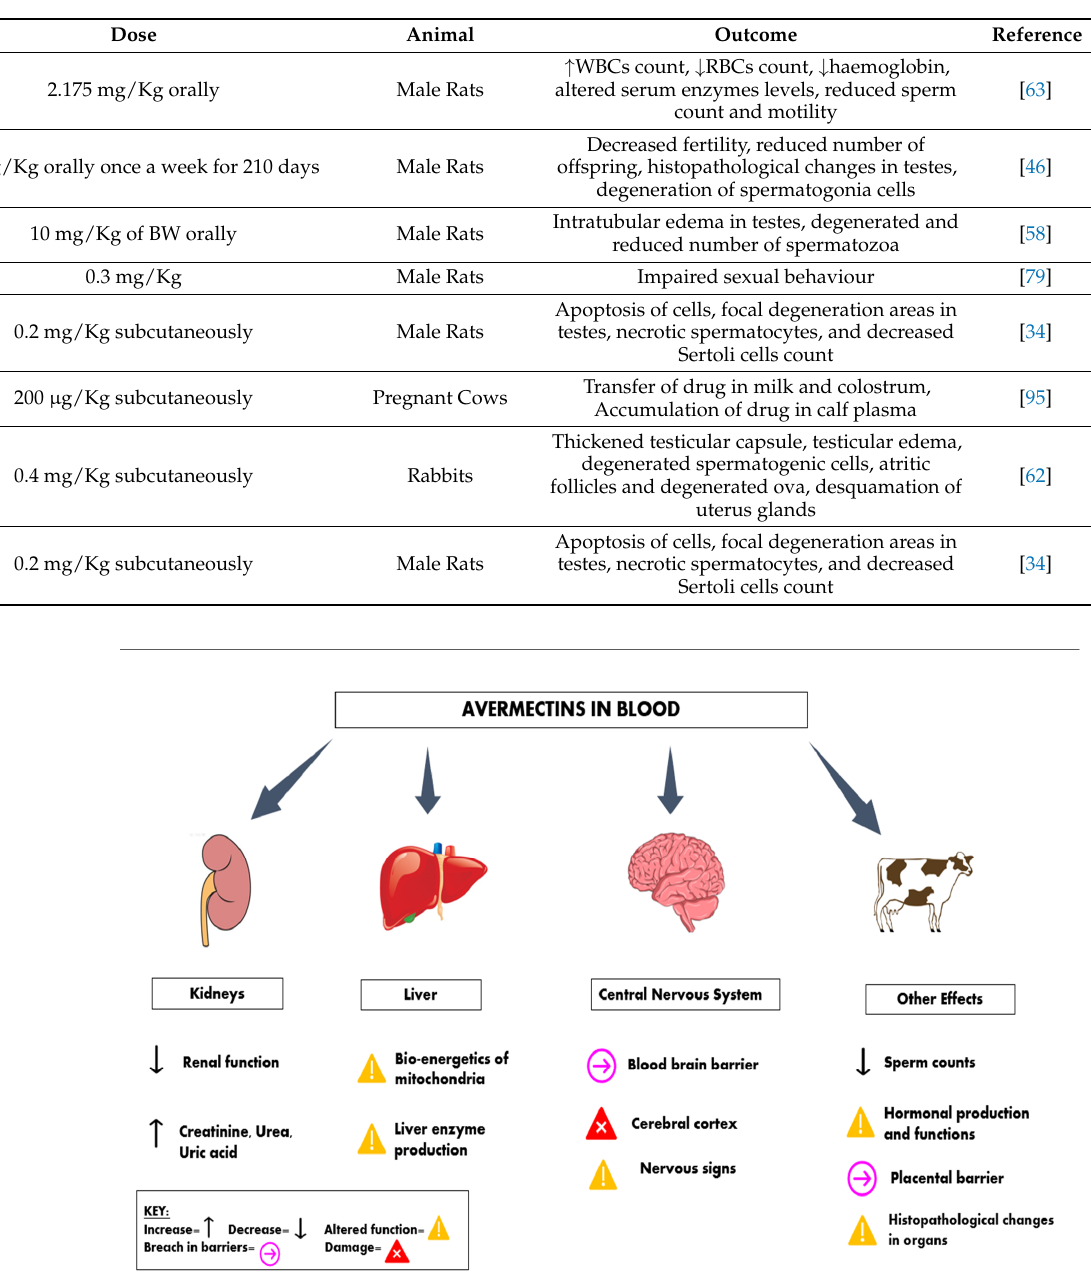
Table 4. Reprotoxic avermectins along with dose, animal, and outcome.